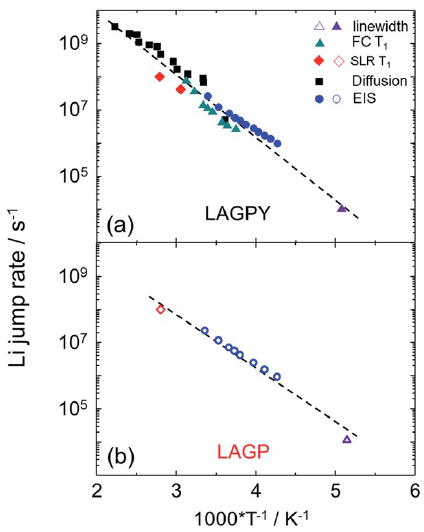
Figure 22. Plots of Li jump rates with inverse temperature for ( a ) LAGPY and ( b ) LAGP, recorded using a combination of linewidth analysis, spin lattice relaxation (SLR) measurements, FC NMR, PFG NMR, and EIS [80] .